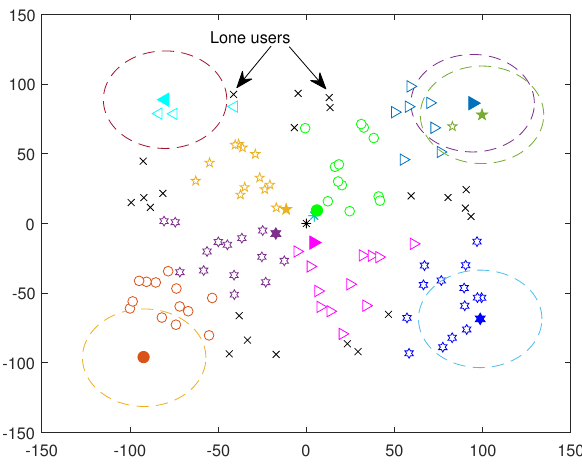
Figure 2. Coalition formation: N = 120 users and 10 coalitions; only one tentative connection.